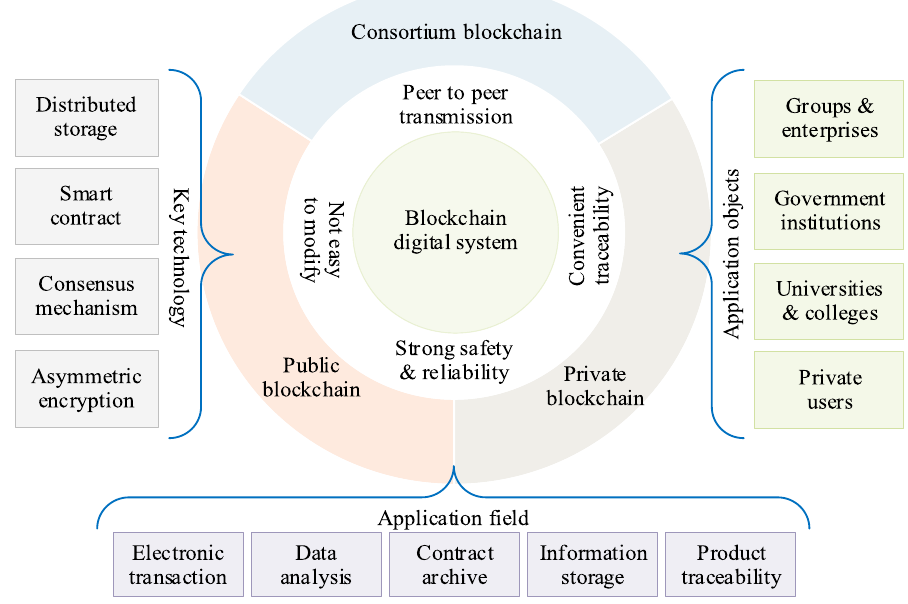
Figure 1. Attribute characteristics of